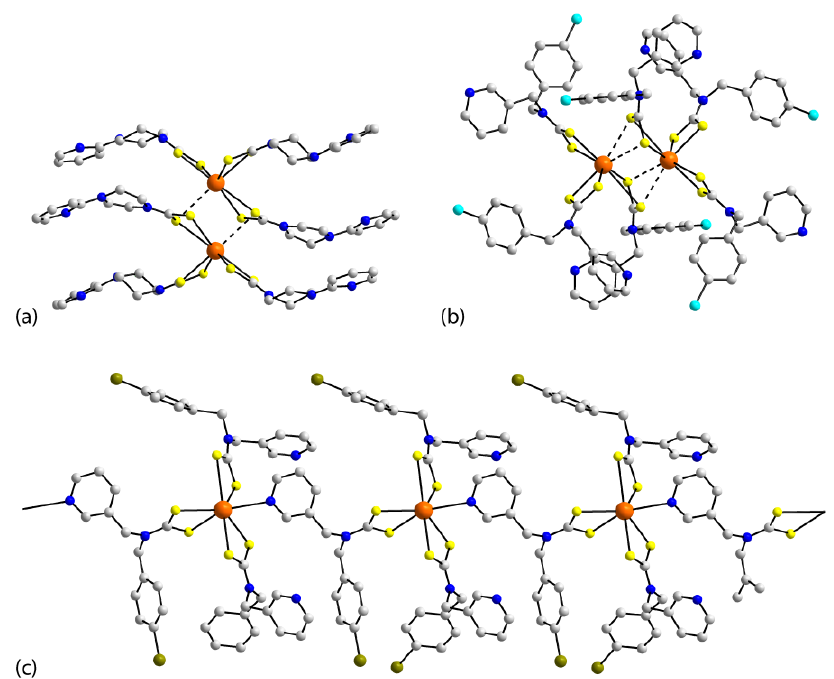
Figure 21. Supramolecular aggregation in the crystals of ( a ) [Bi(L 6 ) 3 ] 2 ( 70 ) and ( b ) [Bi(L 25 ) 3 ] 2 ( 71 ), via Bi · · · S interactions, and ( c ) [Bi(L 29 ) 3 ] n ( 73 ) via Bi–N interactions. Additional color code—bromide, dark-green.